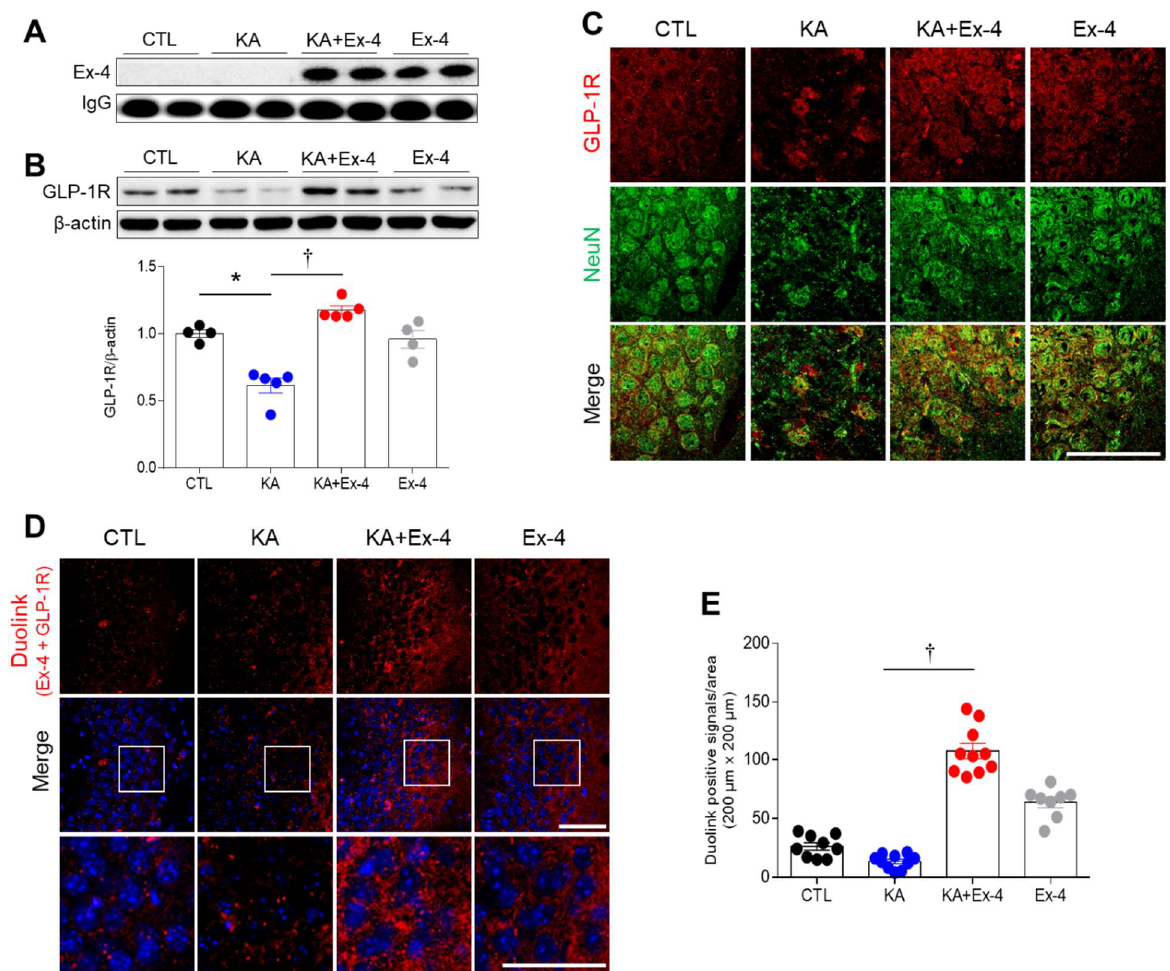
Figure 3. Effects of Ex-4 pretreatment on serum Ex-4 and hippocampal GLP-1R expressions in KA-treated mice. ( A ) Western blot analysis of Ex-4 levels in serum. ( B ) Western blot analysis of expressions of hippocampal GLP-1R. Densitometric values for Ex-4 and GLP-1R were normalized to immunoglobulin G (IgG) and β-actin levels ( n = 4–5 mice per group). ( C ) Representative images of double immunofluorescence showing the co-localization GLP-1R and NeuN in the mouse hippocampus. Scale bar = 50 µm. ( D ) Representative images of Duolink assay showing the interaction of Ex-4 and GLP-1R in the hippocampal CA3 region. Nuclei were stained with 4′, 6-diamidino-2-phenylindole (DAPI). The areas in white squares in the middle panel are magnified on the lower panel. Scale bar = 50 µm. ( E ) Quantitative result of Duolink positive signals are shown in 8-10 CA3 regions ( n = 3–4 mice per group). Data are presented as mean ± SEM. * p < 0.05 vs. CTL, † p < 0.05 vs. KA. The one-way ANOVA was used to detect any statistically significant differences between groups (B and E). GLP-1R/β–actin; p values = 0.0003 (KA), 0.0001 (KA + Ex-4), F (3, 14) = 26.96, E; p values = 0.0001 (KA + Ex-4), F (3, 33) = 96.27.